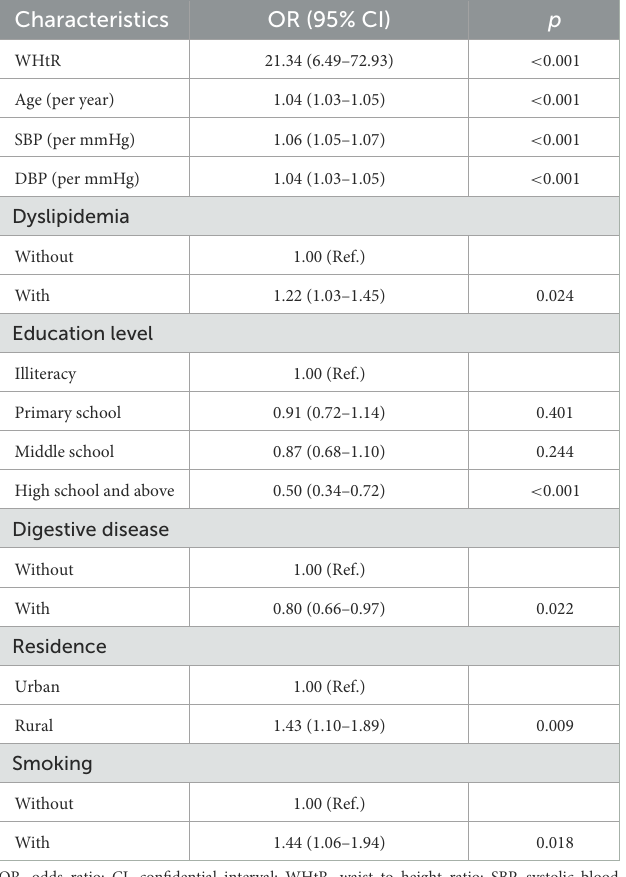
TABLE 2 Risk factors for new-onset hypertension in univariable logistics regression.